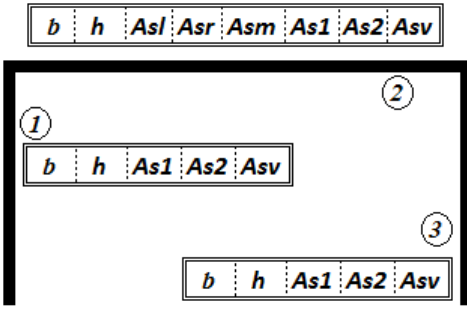
Figure 4. Uniform crossover